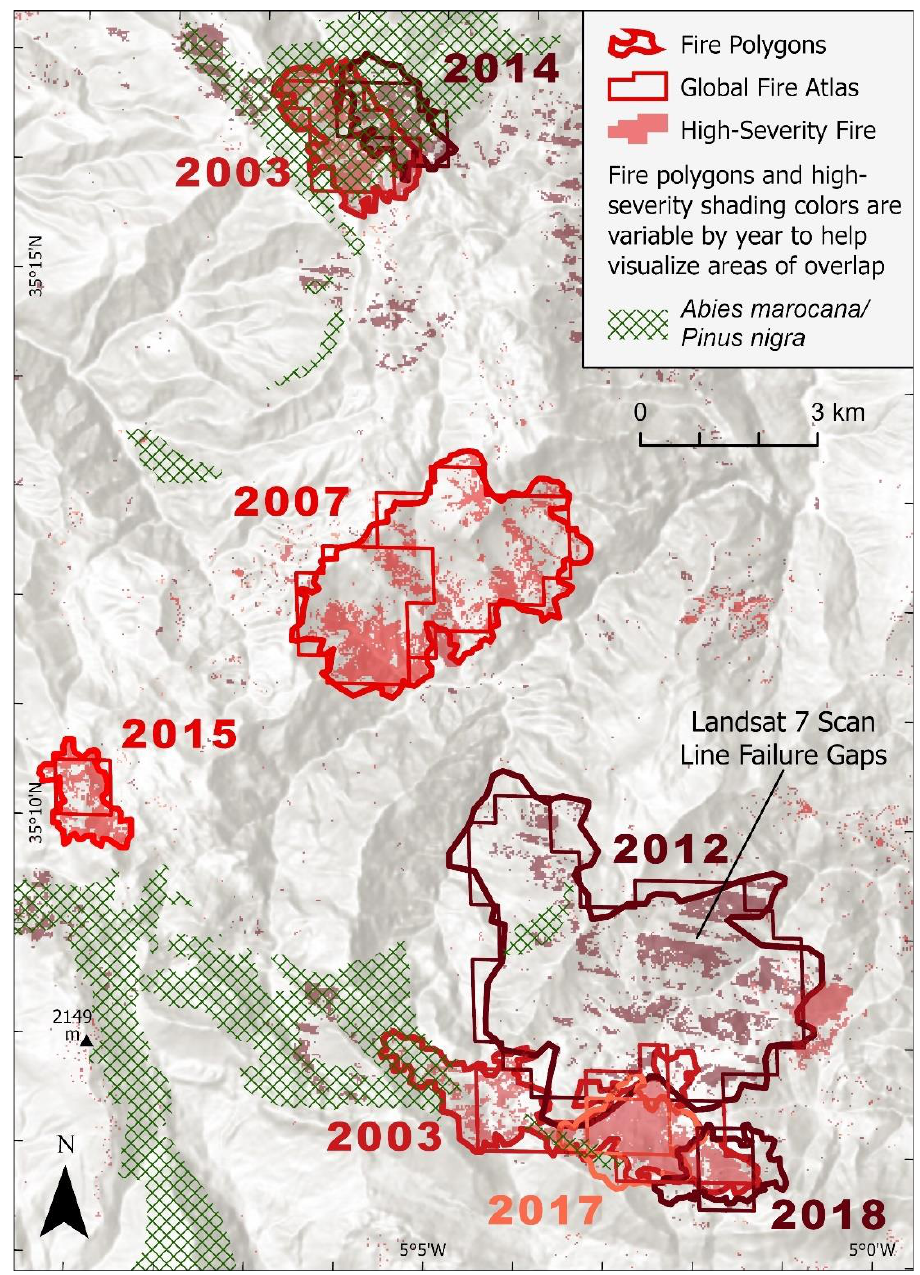
Figure 2. Comparison of Global Fire Atlas (GFA) polygons with fire perimeters digitized from Landsat-derived RdNBR rasters. Additionally, shown are high-severity burn patches and the distribution of Abies / Pinus forest.